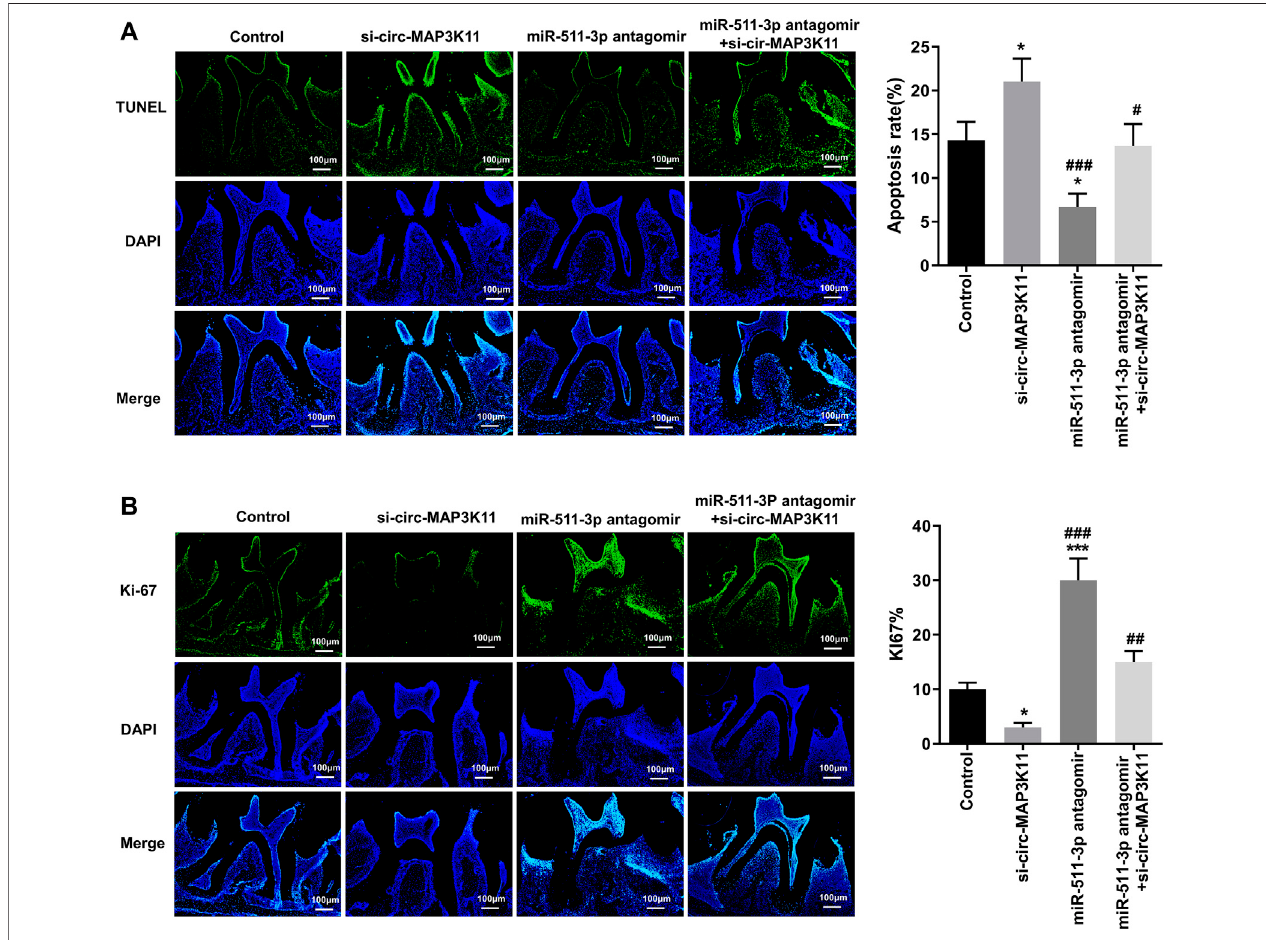
FIGURE 5 | circMAP3K11 represses cell proliferation and induces cell apoptosis by sponging miR-511-3p in vivo (A) The extent of cell apoptosis and (B) proliferation in periodontal tissue from periodontitis mice in which circMAP3K11, miR-511-3p antagomir, or both, were repressed, were investigated respectively by using TUNEL and Ki67